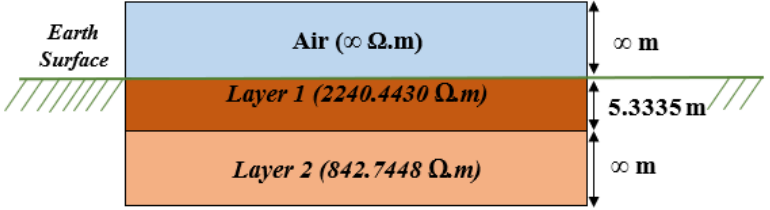
Figure 8. Soil profile interpretation for the Tower T42.